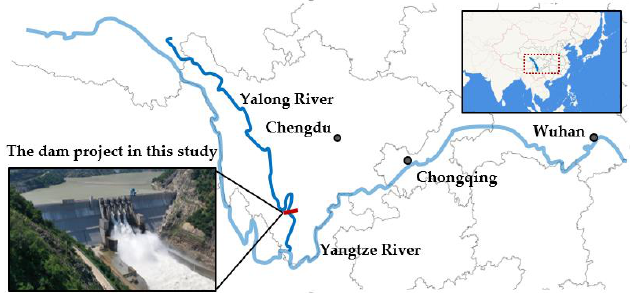
10 of 20 Figure 6. The geographical location and picture of the dam in this study. Considering the representativeness of monitoring points and the completeness of the sequence, we selected the measured values of two deformation monitoring points and one stress monitoring point of the 9# dam section for model development. Figure 7 gives the cross-section of the 9# dam section and the layout of the monitoring points. The height and the foundation elevation of this dam section are 148.0 m and 1186.0 m, respectively.